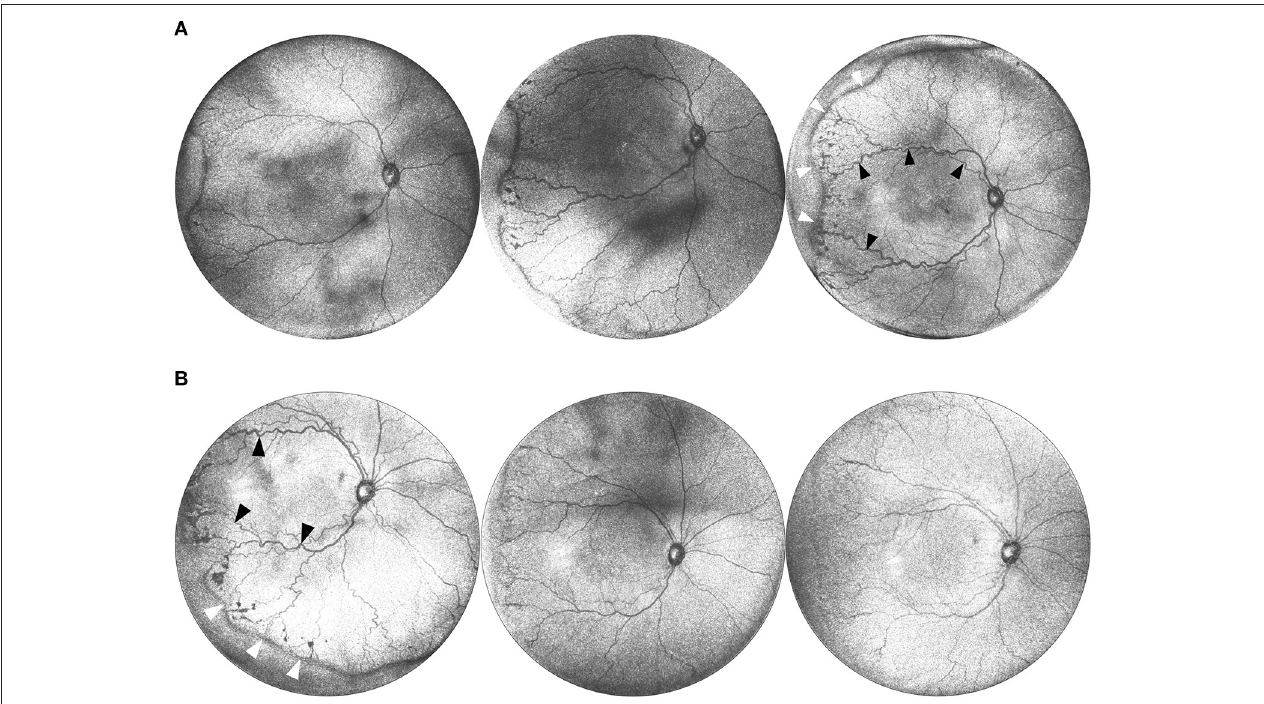
FIGURE 3 | (A) Serial widefield OCT images taken on three successive weeks. These images are from a baby born at 25 weeks gestation (449g) and imaged at 36, 37, and 38 weeks postmenstrual age. Serial imaging shows the posterior and peripheral retina in one image, and tracks the progression of arterial and venous tortuosity and fibrovascular proliferation. Black arrows highlight areas of increased dilation and tortuosity. White arrows indicate the peripheral ridge which has increased over the time period, along with popcorn neovascularization posterior to the ridge. (B) Serial images pre and post treatment. This is the same infant from (A) at postmenstrual age 38, 39, and 40 weeks. The leftmost image shows a posterior en face view taken immediately prior to treatment with 0.625mg intravitreal bevacizumab. Middle image shows regression of disease 1 week after treatment, and rightmost image shows further regression 2 weeks after treatment. Black arrows indicate areas of vascular tortuosity pre-treatment that improve post-treatment. White arrows indicate areas of pathologic neovascularization that appears less dense